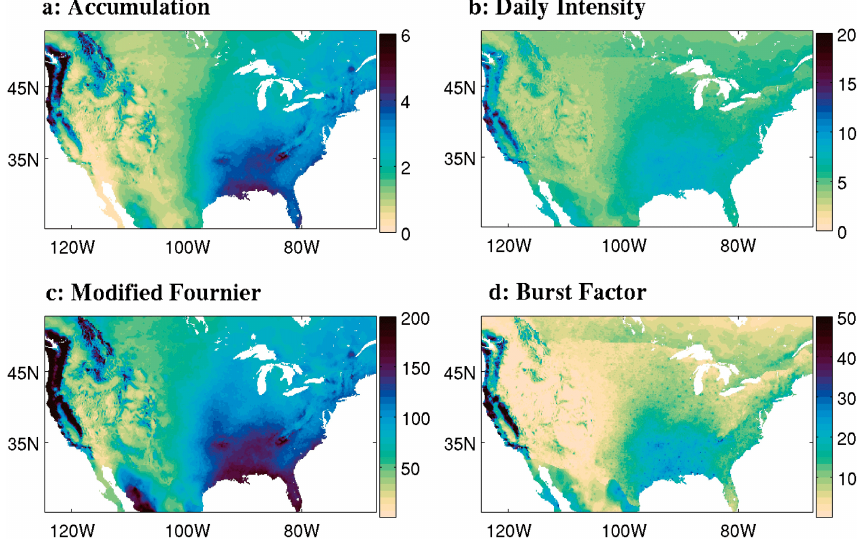
Figure 2. As in Fig. 1, but for the average of 21 downscaled CMIP5 models (the BCCAv2 data set).